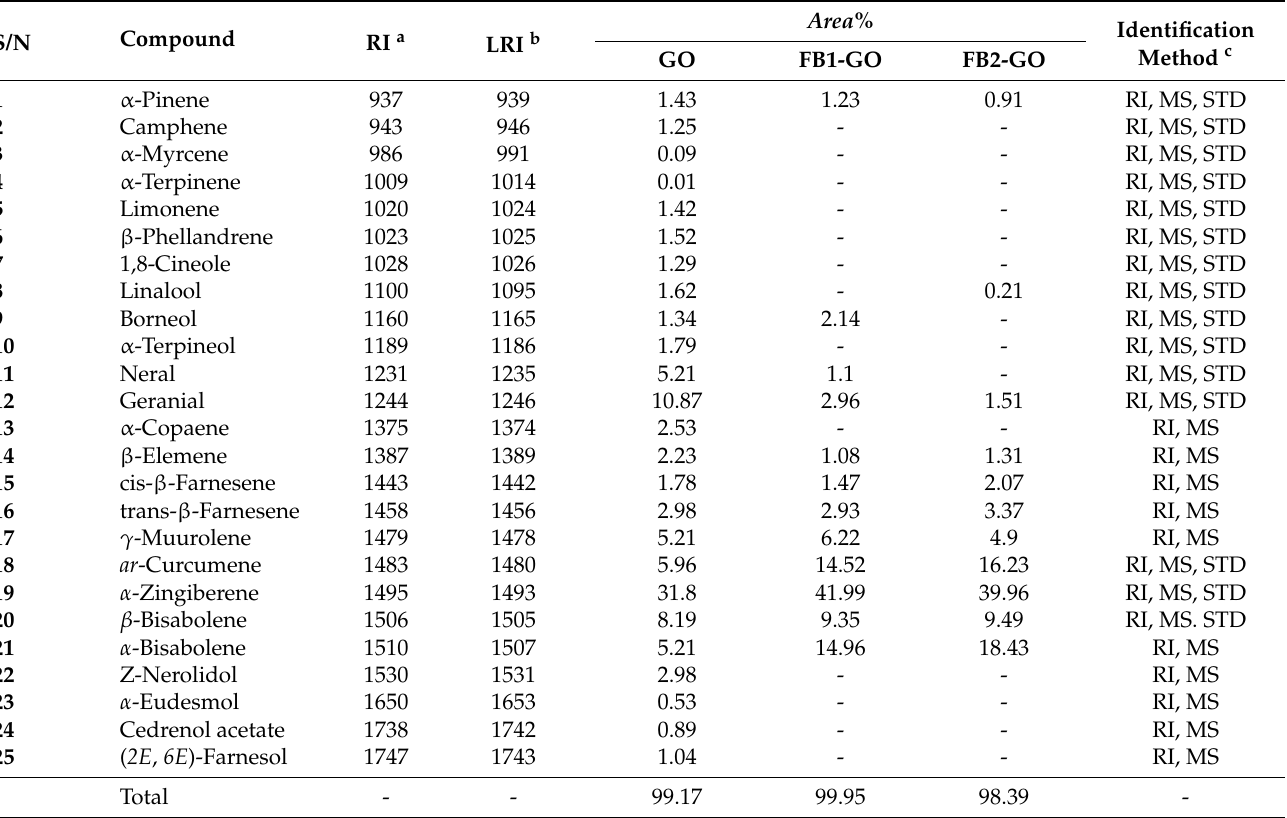
Table 2. The identification of the volatile constituents of the volatile ginger oil using